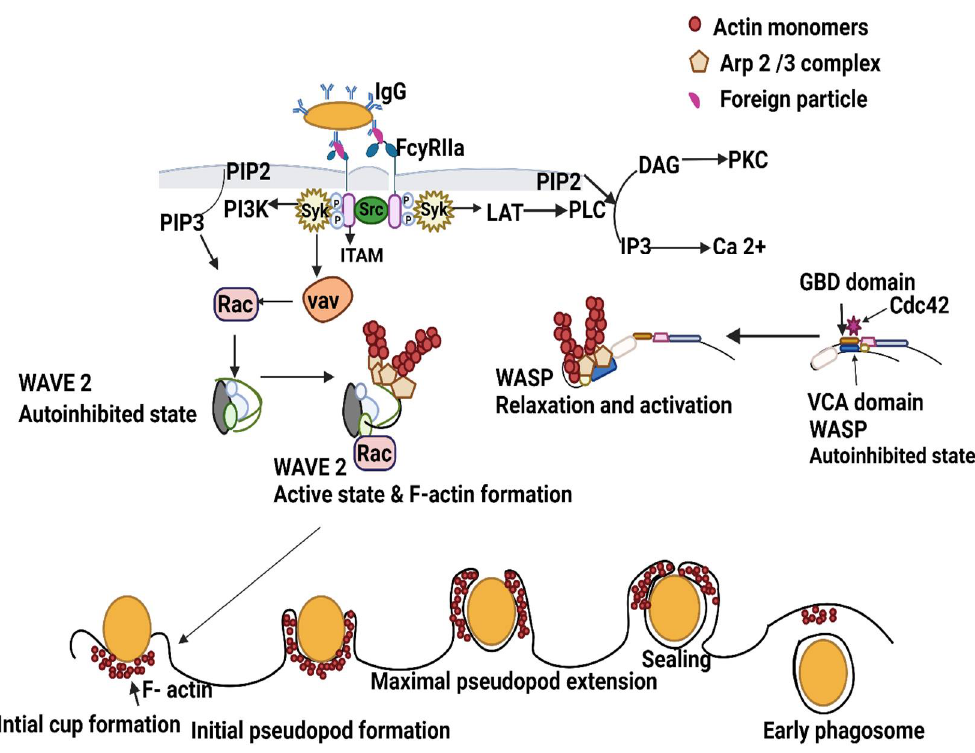
Figure 1. Schematic representation of phagosome formation. Fc γ RIIa crosslinks with IgG bound to foreign particles and induces the activation of Src family kinases, which phosphorylate the tyrosine residues in ITAMs. Then, Syk and phosphorylated ITAMs phosphorylate and activate LAT (linker for T cells activation). LAT, in association with phospholipase C gamma (PLC γ ), produces inositol trisphosphate (IP3) and diacylglycerol (DAG), causing calcium release and the activation of protein kinase C (PKC), respectively. Syk recruits and activates the phosphatidylinositol 3-kinase (PI3K) phosphatidylinositol-3,4,5-trisphosphate (PIP3) at the phagocytic cup. Syk also activates the guanine nucleotide exchange factor Vav, which activates the GTPase Rac. Further, activated Rac and CDC42 activate WAVE and WASP, respectively, from an autoinhibited state to an active state. Activated WAVE and WASP promote actin monomer and Arp 2/3 complex binding to the VCA domain that leads to F-actin formation. Assembly of F-actin nucleation components and F actin formation proceeds with initial cup formation, pseudopod formation, maximal pseudopod formation, sealing or closure, and results in early phagosome formation.